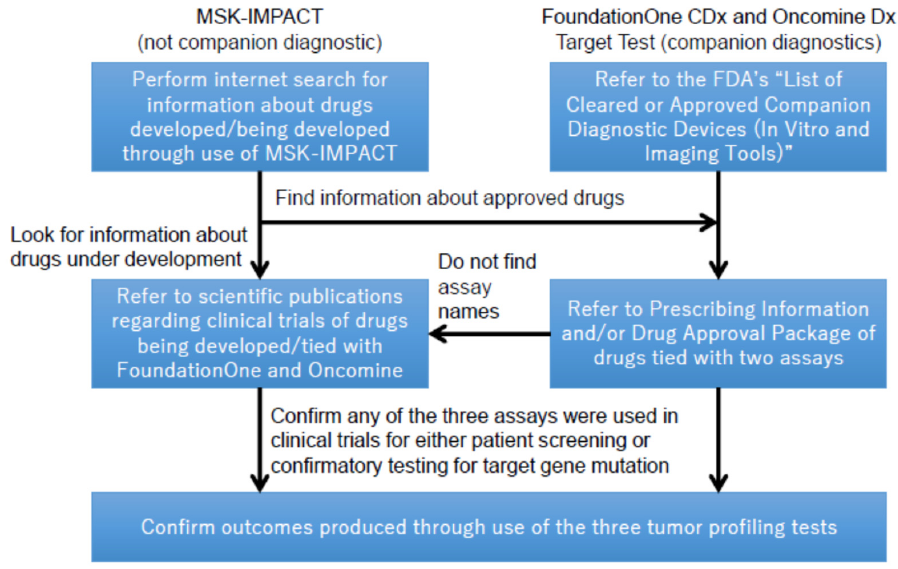
Figure 1. Investigation methods to define contribution to new drug development by the three tu- mor profiling